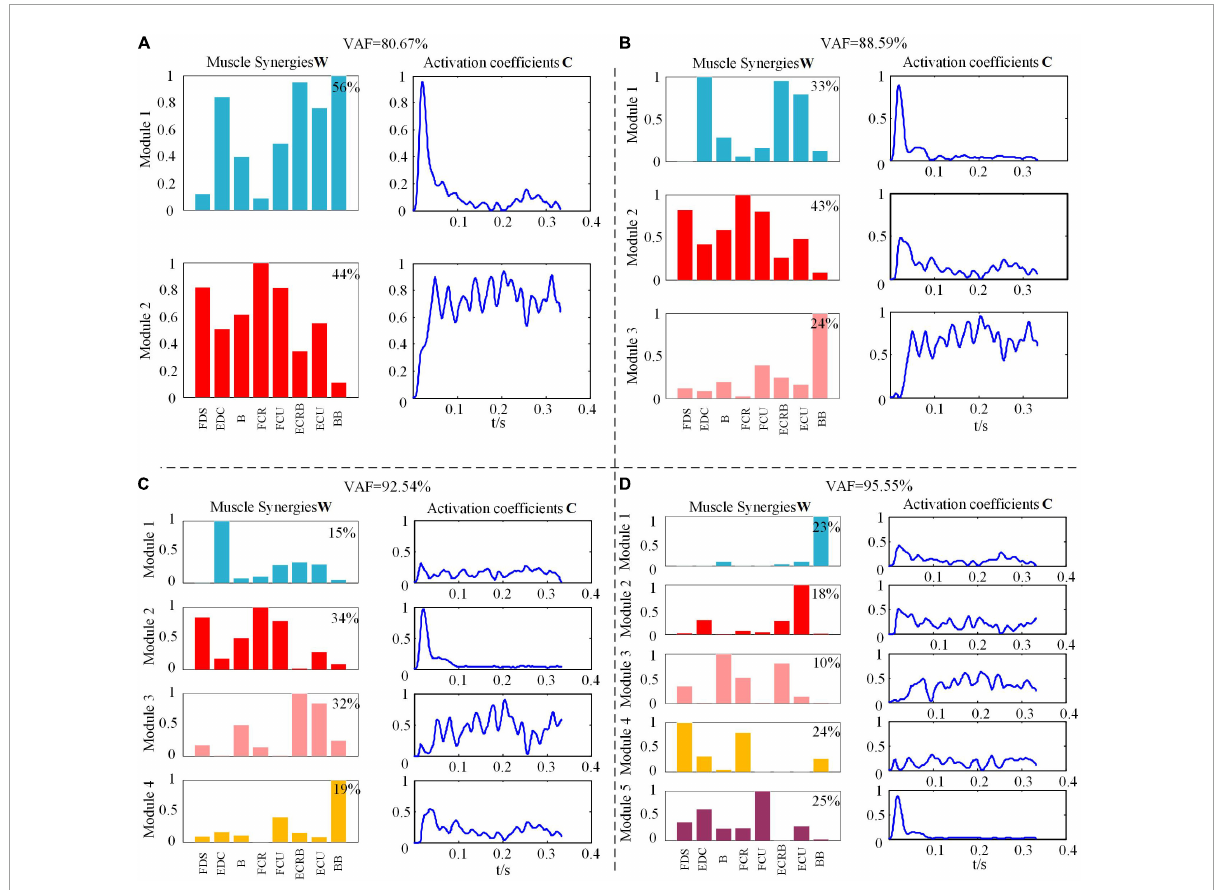
FIGURE2 Muscle synergies matrix and synergy activation coefficient under different module amounts during wrist flexion (WF) movement. (A) The value of variability accounted for (VAF) is 80.67%. (B) The value of VAF is 88.59%. (C) The value of VAF is 92.54%. (D) The value of VAF is